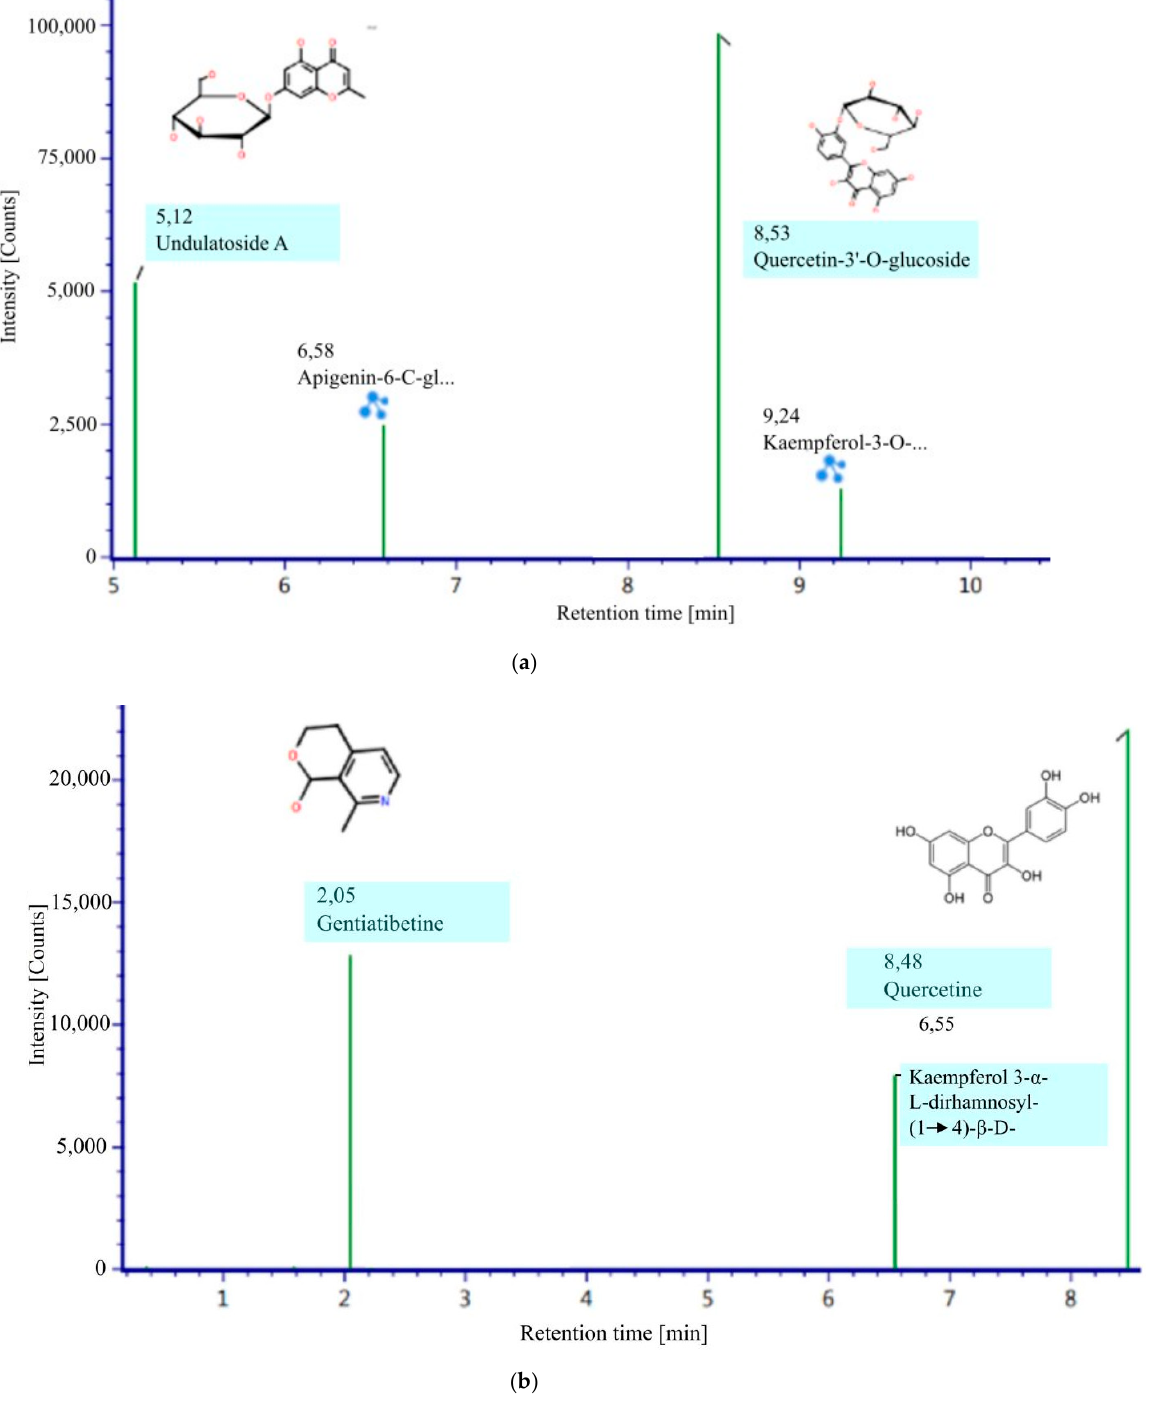
Figure 1. Bioactive compound negative ESI ( a ) and positive ESI ( b ).